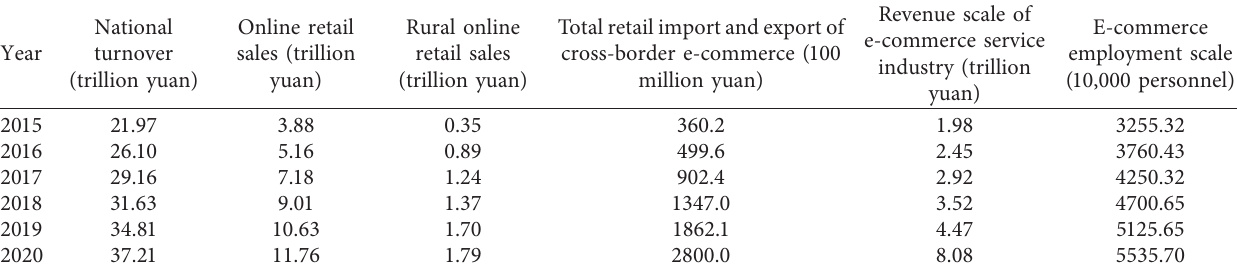
Table 1: Development of e-commerce in China, 2015–2020.